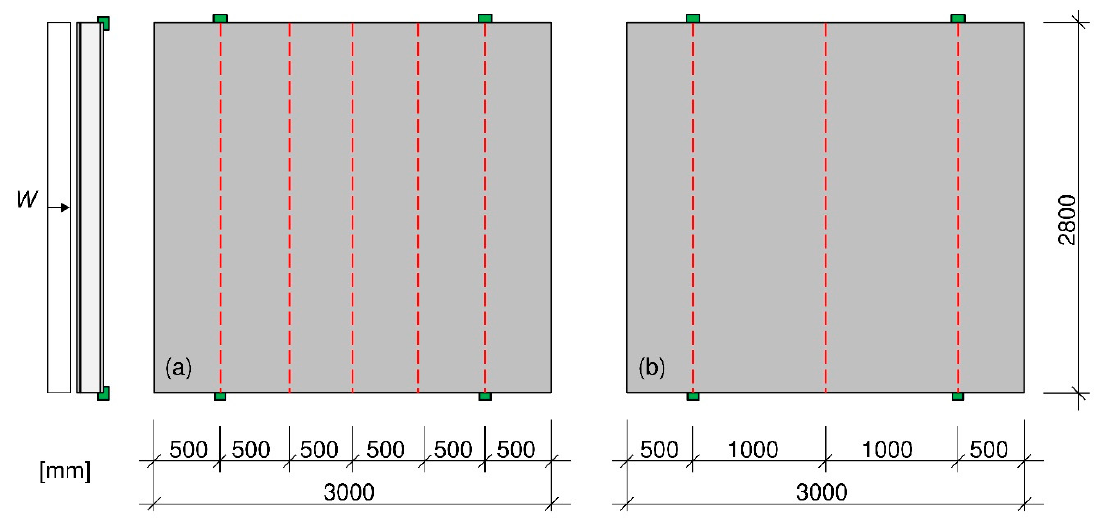
Figure 7. Illustration of wind load test on full sandwich elements: ( a ) single connector configuration (S) and ( b ) double connector configuration (D).